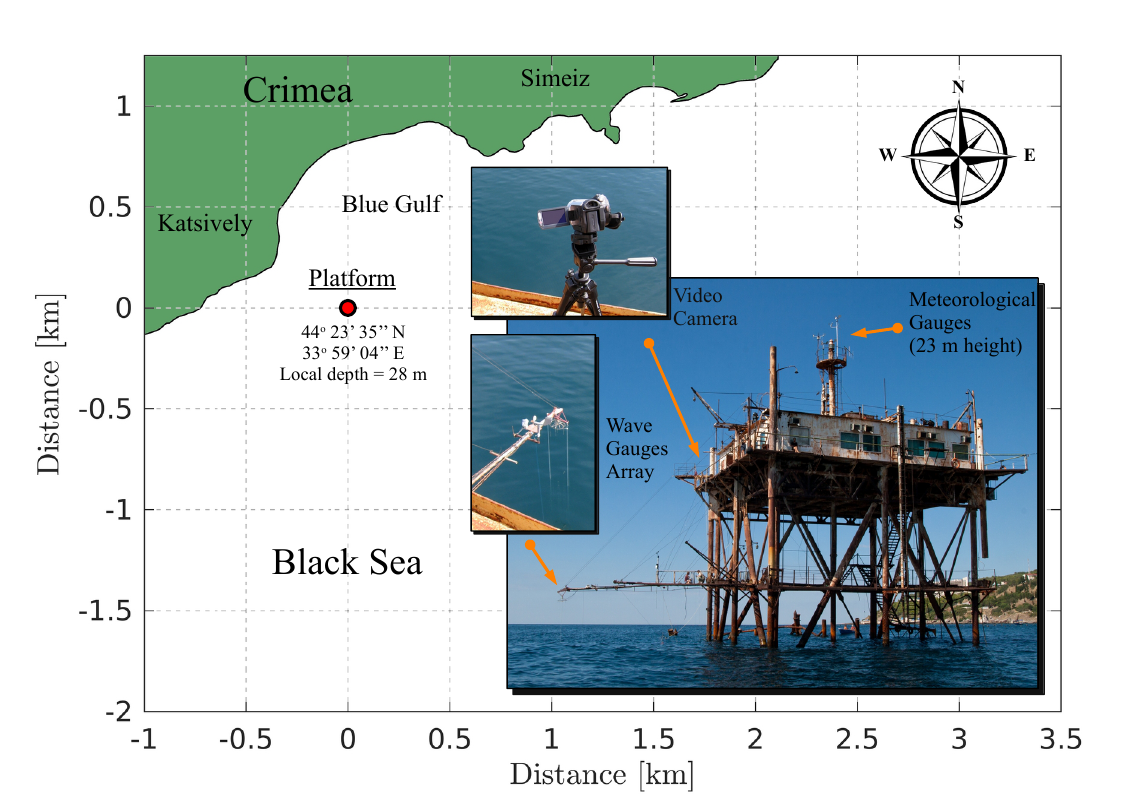
Figure 1. Location of the Black Sea research platform and a general view on the